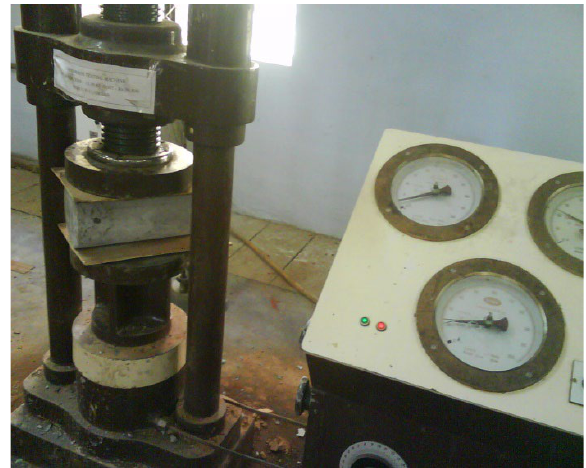
Figure 3. Split tensile test setup.